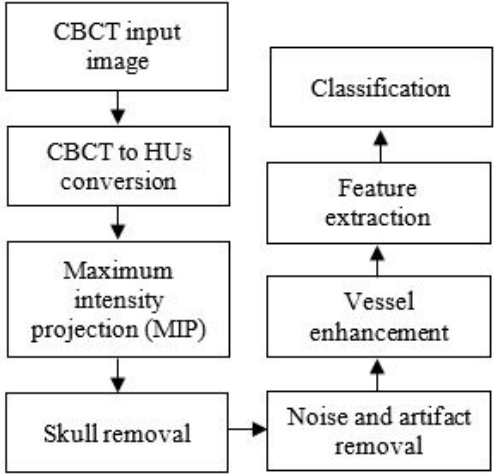
Figure 1. The flowchart of the proposed collateral vessel